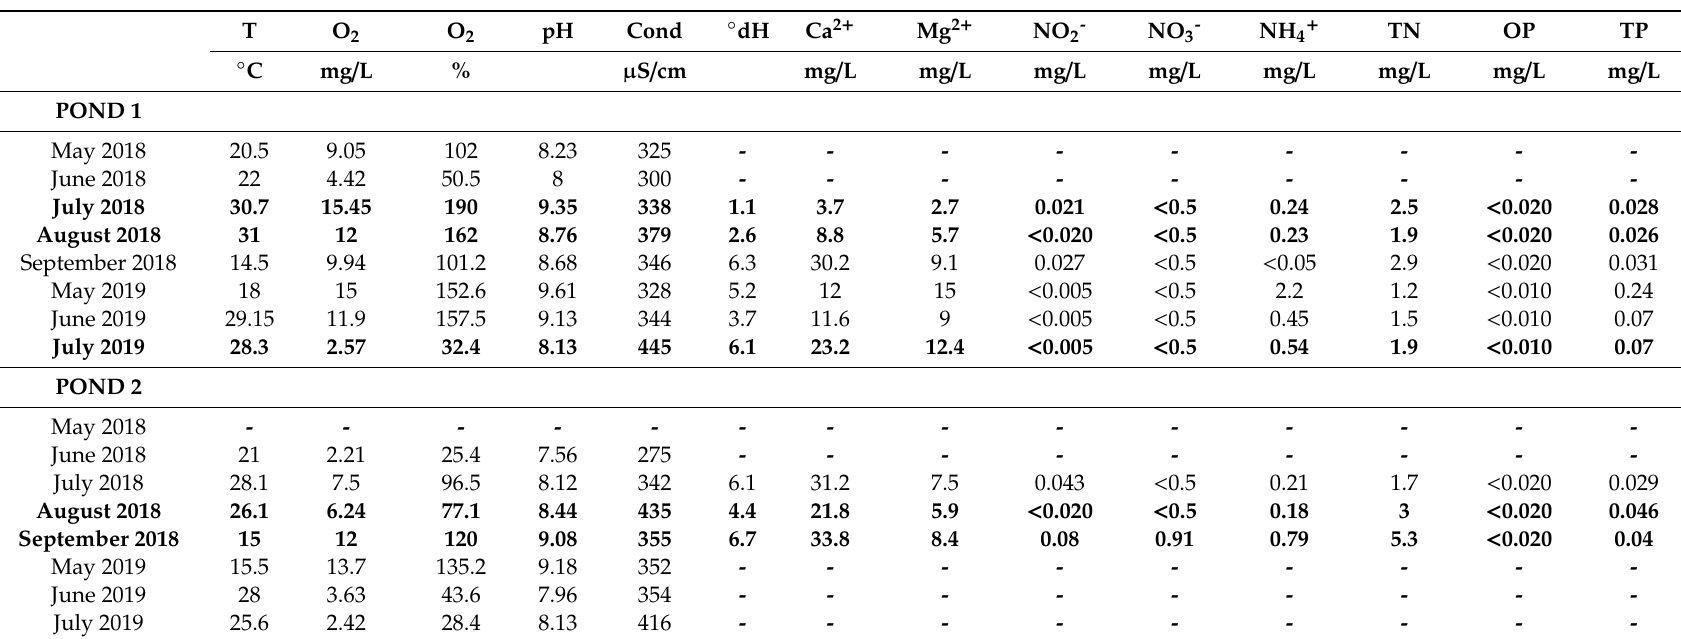
Table 1. Environmental parameters measured in pond 1 and pond 2 in 2018 and 2019. Bold is for the dates when Chara baueri was found in ponds. Water temperature (T), oxygen concentration / saturation (O 2 ), pH, conductivity (Cond.), degree of General Hardness of water ( ◦ dH), calcium ions concentration (Ca 2 + ), magnesium